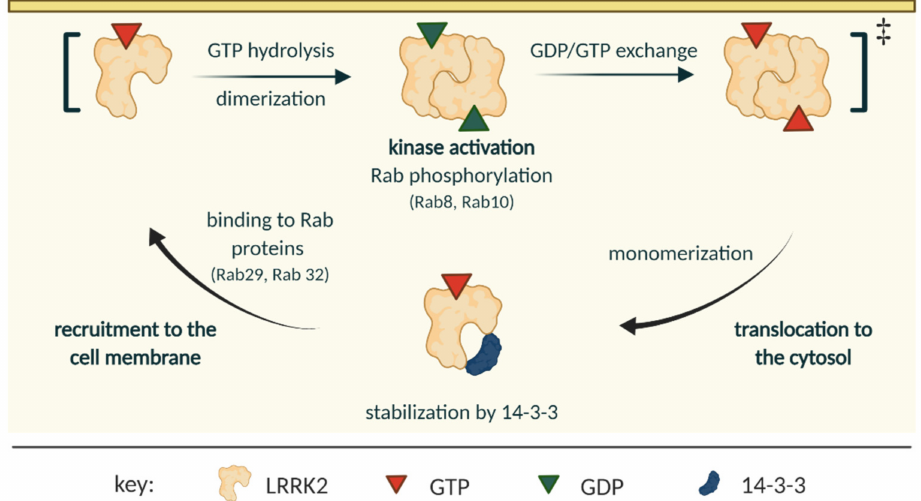
Figure 2. Current (simplified) model of the LRRK2 cycle. LRRK2 exists as monomers in the cytosol, where it is stabilized by 14-3-3 proteins. Upon binding to Rab proteins, LRRK2 is recruited to biolog- ical membranes, where the kinase domain of LRRK2 gets activated, the GTP hydrolyzes, and the protein dimerizes. The exact order in which these processes happen is unknown, but it is possible that they occur simultaneously. After the signaling output is achieved, GDP is exchanged to GTP, and the protein monomerizes and gets translocated to the cytosol. The figure is based on reference [52]. Association to microtubules was left out on purpose, as it remains to be experimentally proven to be true for endogenous LRRK2; figure created with BioRender.com (access date 2 April